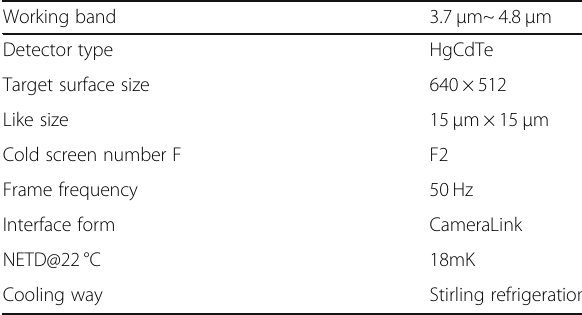
Table 1 Parameters of the test system detector Working